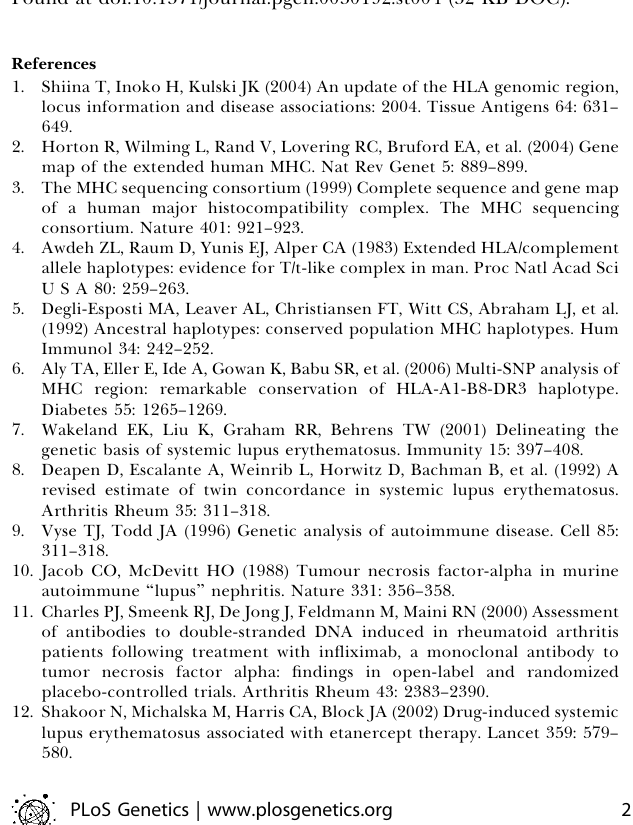
Table S1. Quality Control Information for Four-Digit HLA-DRB1 Typing and All 86 SNPs Chosen for Genotyping in a Cohort of 314 UK SLE Trios Found at doi:10.1371/journal.pgen.0030192.st001 (26 KB XLS). Table S2. OR and TDT Data for Four-Digit HLA-DRB1 Typing in a Cohort of 314 UK SLE Trios Found at doi:10.1371/journal.pgen.0030192.st002 (20 KB XLS). Table S3. Complete Single Marker (SNP) and HLA-DRB1*0301 Association Data in a Cohort of 314 UK SLE Trios Found at doi:10.1371/journal.pgen.0030192.st003 (34 KB XLS). Table S4. Association of HLA-DRB1*0301 Genotypes with SLE Subphenotypes in 314 UK SLE Probands Found at doi:10.1371/journal.pgen.0030192.st004 (32 KB